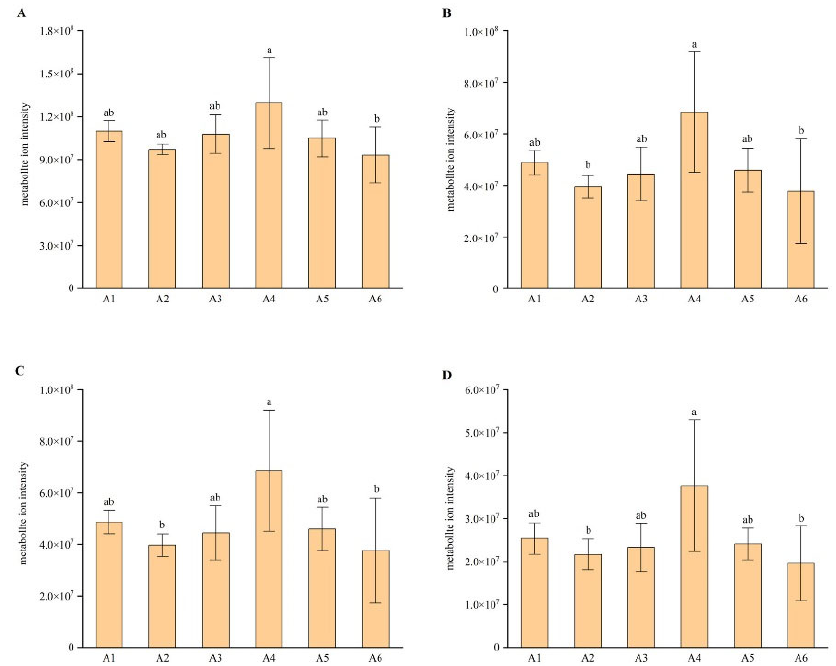
Figure 10. Change in total content of flavonoids with lower binding energy than positive control. The plots represent: ( A ) changes in the total contents of 26 flavonoids with lower binding energy to 3CLpro than to the positive control; ( B ) changes in the total contents of 12 flavonoids with lower binding energy to RdRp than to the positive control; ( C ) changes in the total contents of 11 flavonoids with lower binding energy to PLpro than to the positive control; ( D ) changes in the total contents of 5 flavonoids with lower binding energy to spike protein than to the positive control. Different letters above each column indicate significant differences between the total content of flavonoids which have lower binding energy than positive control of each month. The same letter above each column indicates no significant difference between the total content of flavonoids which have lower binding energy than positive control of these